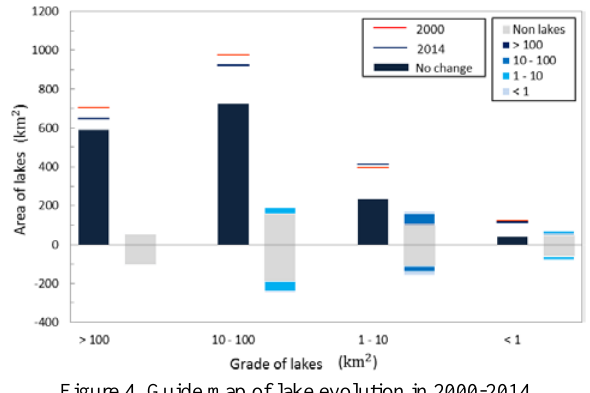
Figure 4. Guide map of lake evolution in 2000-2014